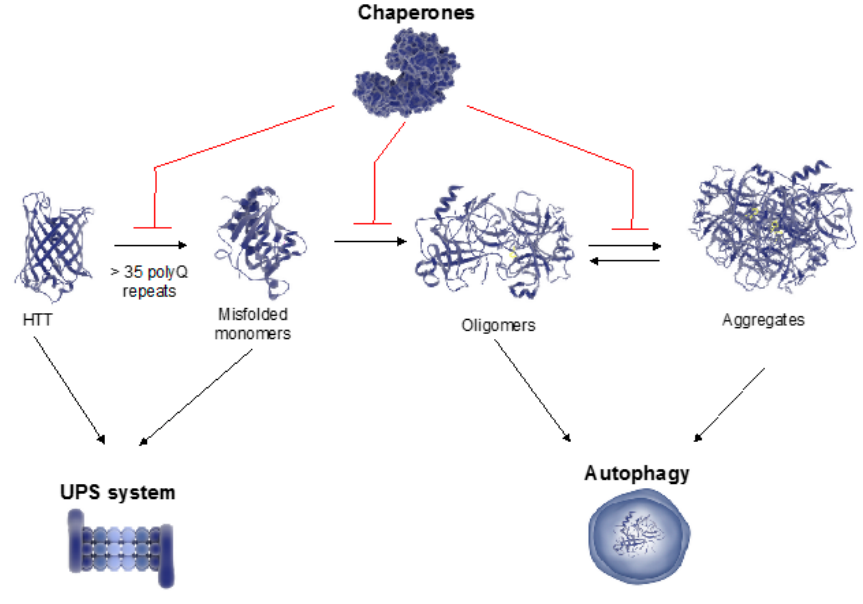
Figure 3. The proteostasis network reduces aggregation and proteotoxicity of mutant HTT. Different proteostasis nodes such as the chaperome network, the UPS and autophagy-lysosome pathways, control the folding, aggregation and clearance of HTT. Chaperones participate at distinct levels of HTT proteostasis, including the regulation of aggregation and disaggregation processes to reduce the accumulation of aberrant inclusions and/or intermediates. If refolding activities are not sufficient to assure the proper function of HTT, chaperones may also promote its degradation through protein clearance mechanisms. The UPS is mostly involved in the degradation of HTT monomers whereas autophagy can degrade large polyQ-expanded HTT aggregates.